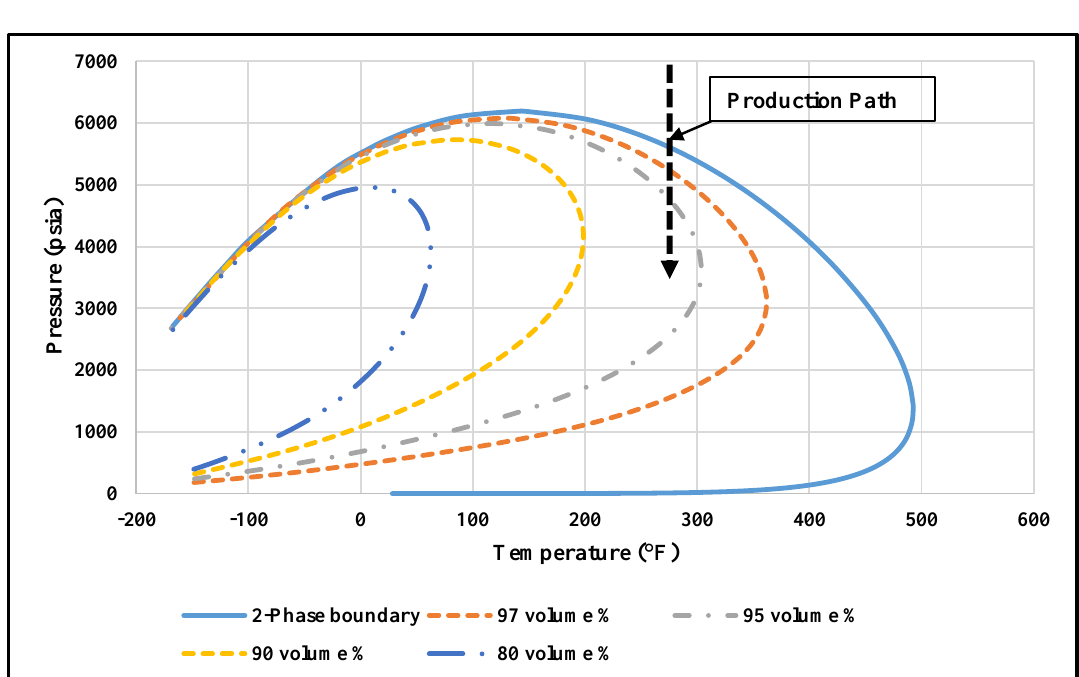
Figure 11. Two-phase diagram for the gas condensate reservoir under consideration. The straight line indicates the assumed isothermal pressure depletion program.